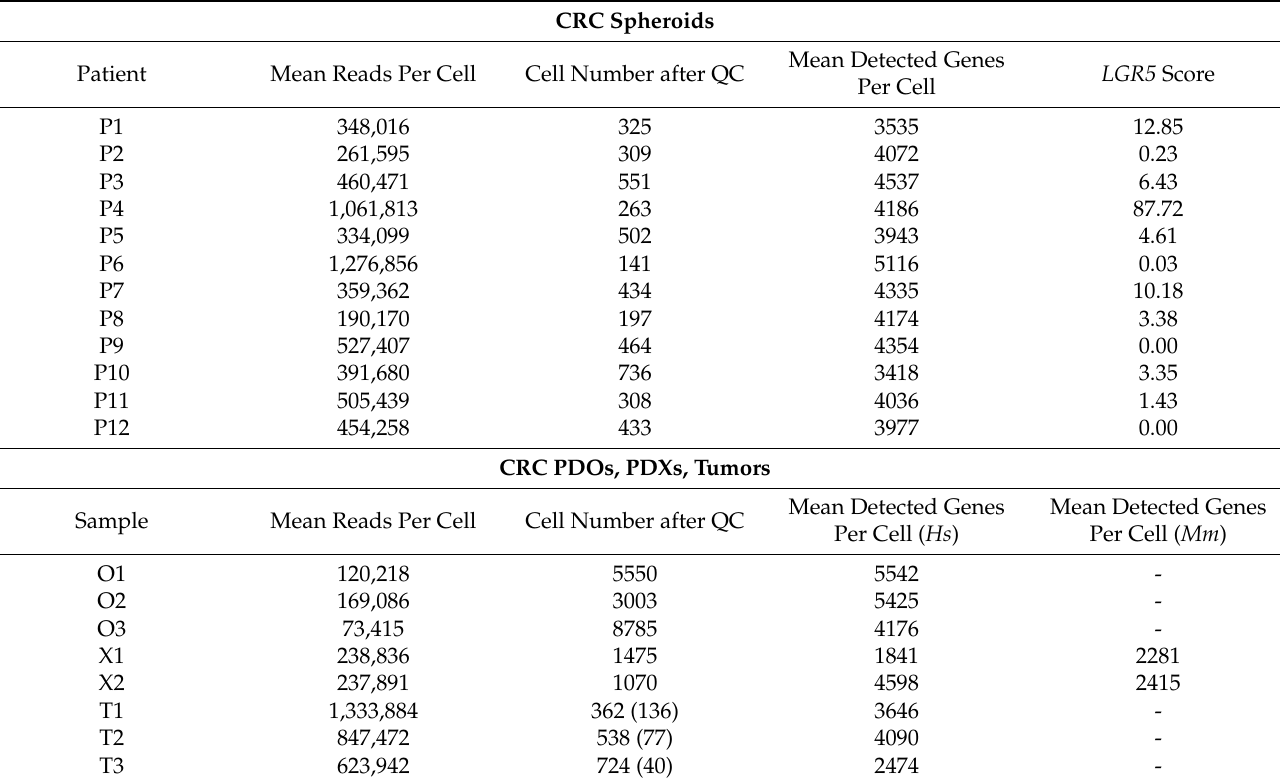
Table 2. Single-cell RNA-sequencing analysis. Top: Colorectal cancer (CRC) spheroids (P1–P12). Cultures with an LGR5 score (= LGR5 read counts/cell number) >1 are considered LGR5 + . Bottom: patient-derived organoids (PDOs; O1–O3), patient-derived xenografts (PDXs; X1, X2), and tumors (T1–T3). Cell numbers for X1 and X2 indicate human cells. Cell numbers in brackets indicate epithelial cells used for analysis of T1–T3. Hs , Homo sapiens ; Mm , Mus musculus ; QC, quality